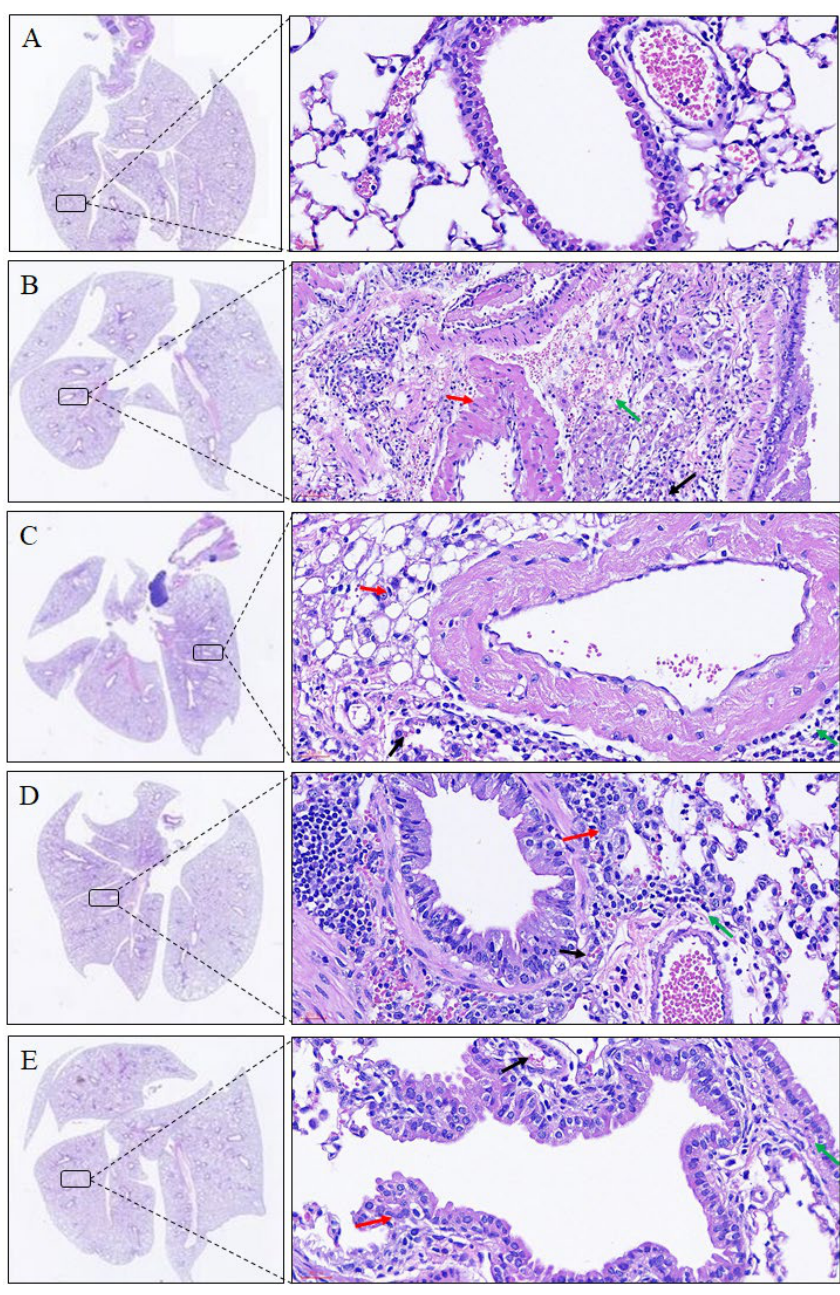
Figure 3. Lung histological examination results for Der p -induced allergic mice treated with imperatorin. Eosinophil is indicated by black arrow, macrophage is indicated by red arrow, and lymphocyte is indicated by green arrow. Hematoxylin–eosin staining results are presented at 400× magnification. ( A ) Control group; ( B ) Der p group; ( C ) Der p ± imperatorin 1 mg/kg group; ( D ) Der p ± imperatorin 5 mg/kg group; ( E ) Der p ± imperatorin 10 mg/kg group.